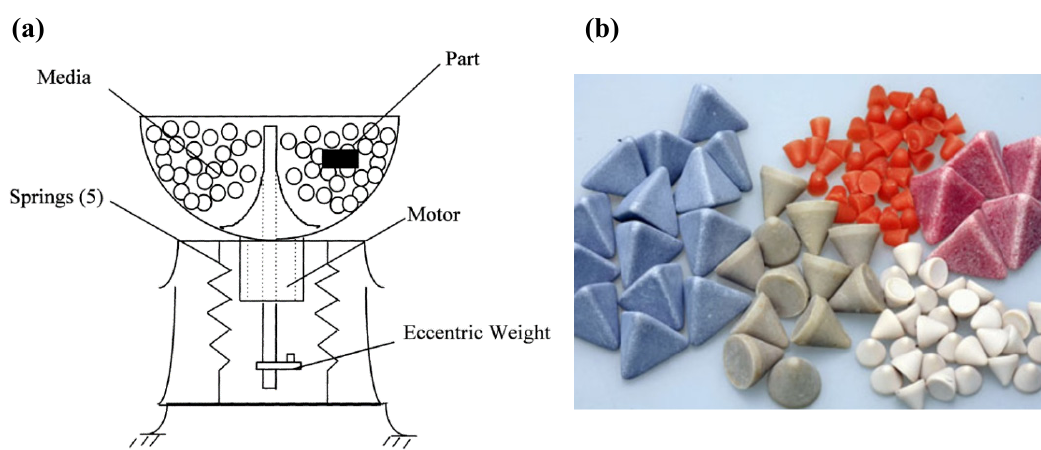
Figure 16. ( a ) Schematic diagram of vibratory polishing [109]; Reprinted with permission from [109]; 2000 Elsevier. ( b ) Abrasive media with different geometries and multiple parts subjected to vibratory polishing [110]. Reprinted with permission from [110]; 2001–2020VibraFinish.